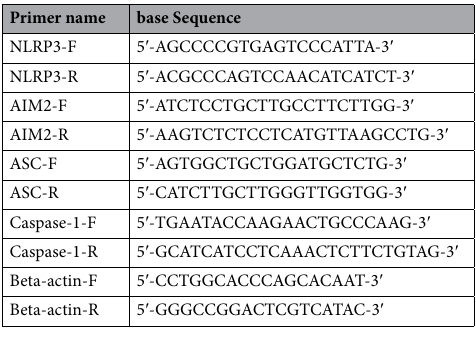
Table 1. Primer sequence